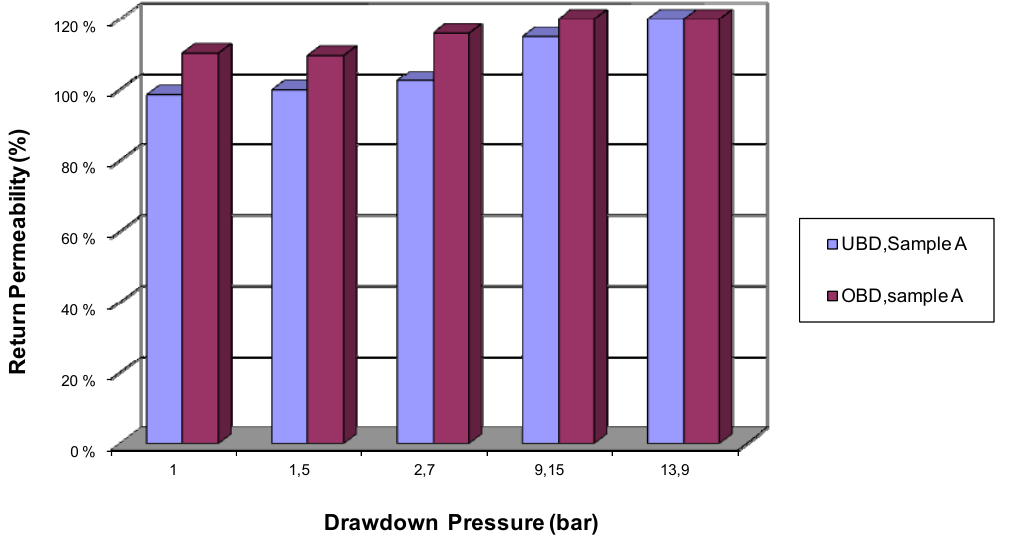
Figure 3. Permeability & Drawdown in post UBD and OBP-sample A.